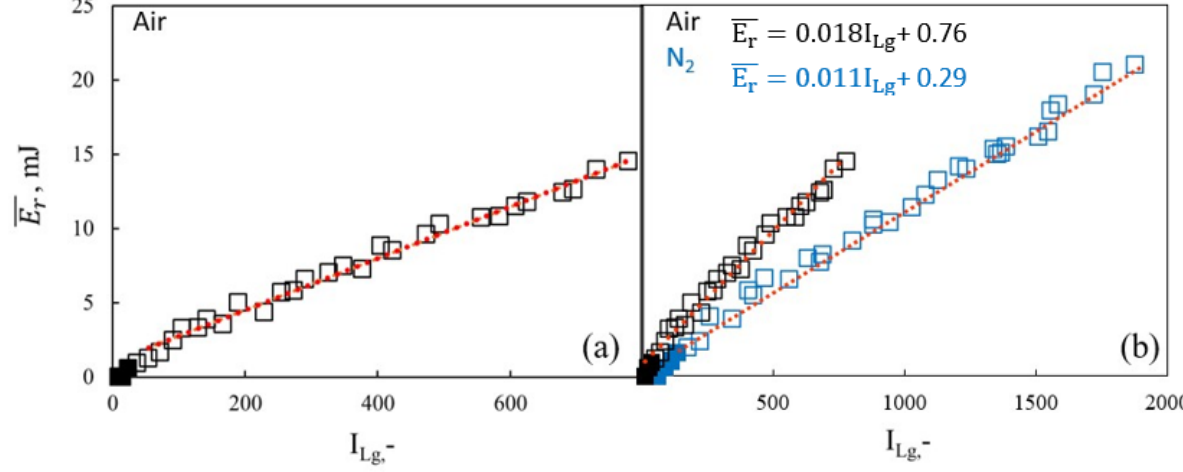
Figure 11. Correlation between E r and I Lg for all tested V d in air ( a ) and comparison with nitrogen results ( b ). The dashed red lines represent a linear fit between E r and I Lg for both analyzed